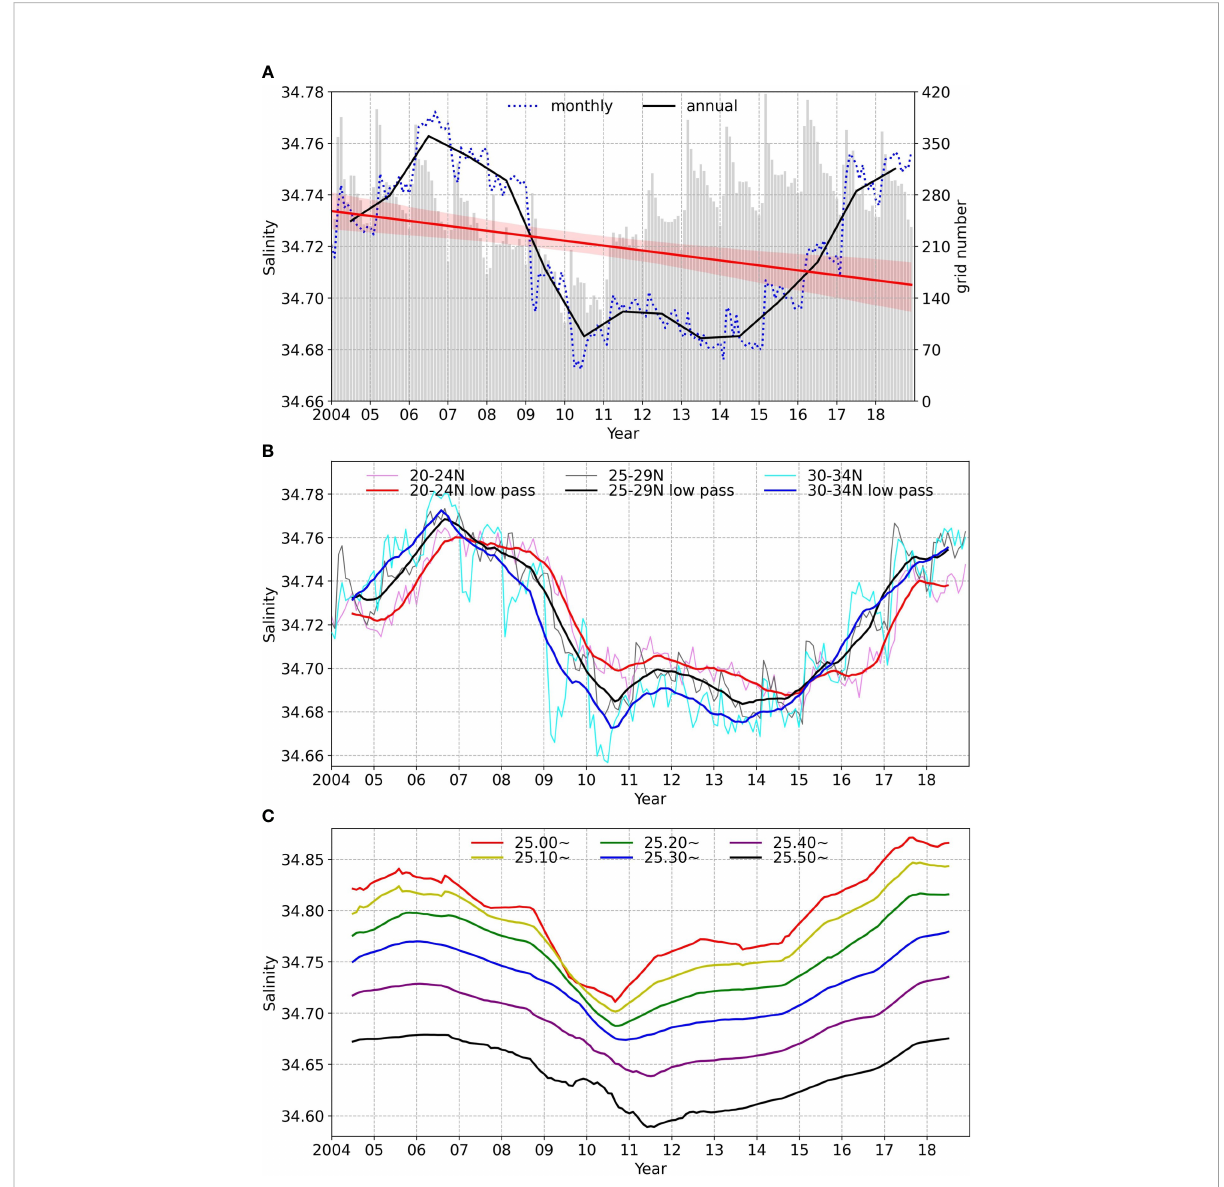
FIGURE 5 Time series of salinity in the STMW based on the criteria in Figure 1B. (A) Monthly (dotted blue), annual mean (solid black), and linear trend (solid red) with a 95% con fi dence interval (red band) of salinity. The values were weight-averaged at each grid by thickness of a g surface. Gray bars represent the average number of 1°×1° grid, which were used on one g surface. (B) Salinity weight-averaged by thickness in three latitude ranges. Pink (monthly) and red (12-month moving average) for 20 – 24°N, gray and black for 25 – 29°N, and light blue and blue for 30 – 35°N. (C) 12-month moving average salinity averaged on surfaces at g = 25.00 – 25.05 (red), 25.10 – 25.15 (yellow), 25.20 – 25.25 (green), 25.30 – 25.35 (blue), 25.40 – 25.45 (purple), and 25.50 – 25.60